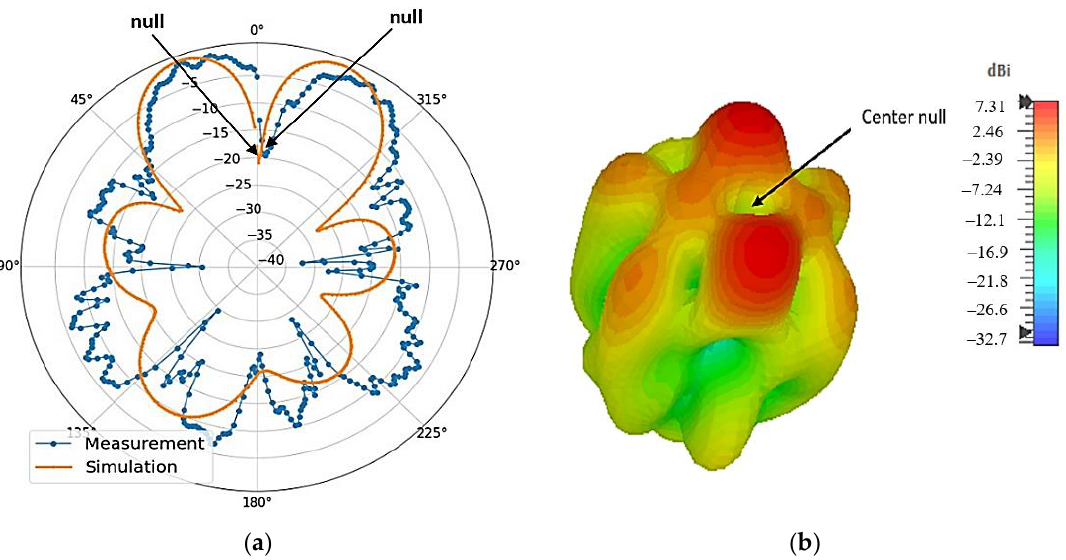
Figure 9. Far-field results at 3.56 GHz. ( a ) Simulated and measured 2D radiation patterns in E plane; ( b ) simulated 3D radiation pattern.